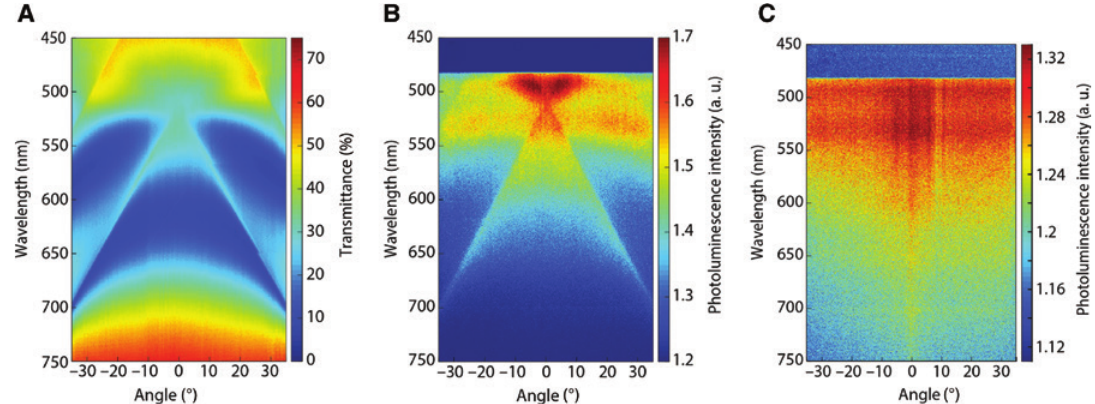
Figure 4: Angle-resolved spectra of Ag arrays with hBN. (A) The transverse magnetic (TM) transmission spectrum of 345 nm-period/150-nm-pillar-diameter array studied in Figure 1 but with overlaid hBN. (B) The coupled PL from the hBN film on the same array with illumination from a 460 nm CW diode laser. (C) The angle-resolved PL spectrum from hBN on the 2000 nm pitch array with 150 nm diameter pillars. The SLRs in the visible wavelength range are not supported due to the large spacing between the